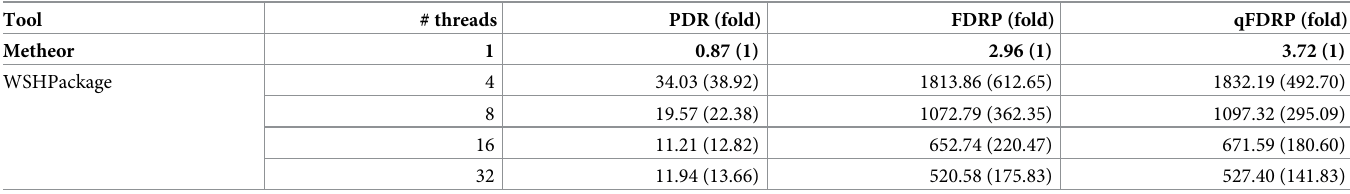
Values denote the wall time in minutes to compute each measure. Fold speedups in corresponding run of Metheor are shown in